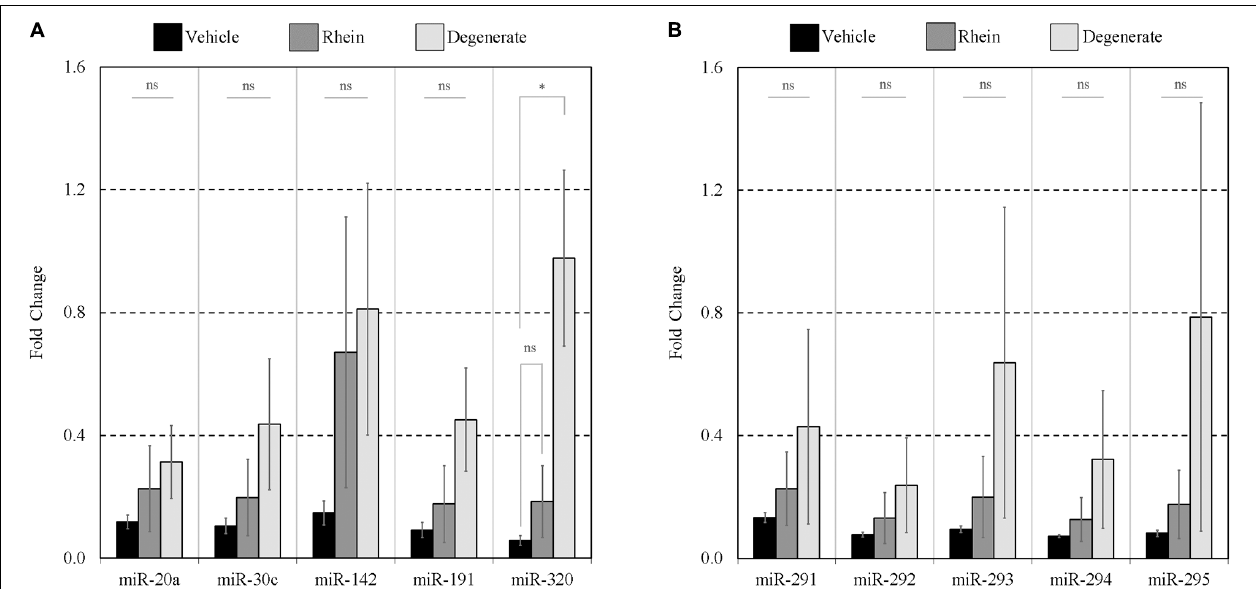
FIGURE 8 | Extent of panel miRNA release between vehicle control, rhein treated, and degenerate embryos. Preferential release of each panel miRNA between embryo groups was assessed by comparing the amount found extracellularly to that intracellularly. Each extracellular miRNA comprising panels (A,B) is normalized against its intracellular counterpart. n = 3. Error bars = SEM. ∗ p < 0.05.